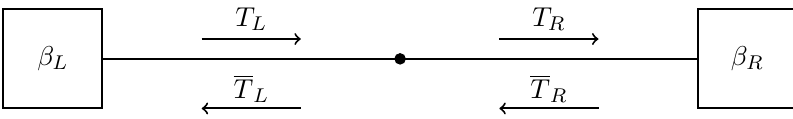
Figure 13 . Same as in (cid:12)gure 12, with an impurity depicted as a black